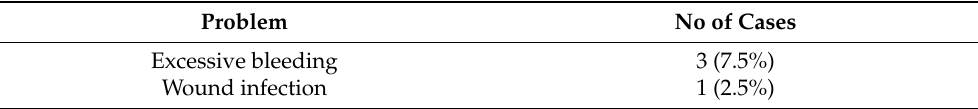
Table 5. The occurrence of early complications after the procedure of cancellous bone harvesting from the proximal